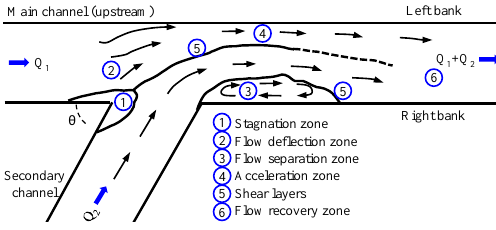
Figure 1. Hydrodynamics at open-channel junctions. Here we plot the six characteristic regions. Steady-state bed bathymetry at junctions presents two salient morphological features [50]: a scour-hole on the downstream corner of the junction, and a bar on the left bank closed to the downstream side of the confluence, denoted as a bank-attached lateral bar. Scour hole depth varies non-linearly with the confluence angle [45,51,52]. The bar appears due to the lower water depth and recirculating flow in the separation zone, as well as the flow detaches from the left sidewall downstream of the junction. Moreover a helicoidal flow emerges in the main channel downstream of the junction [50], which is responsible for the movement of water in the vertical direction and the concentration of the finest sediments in the bar